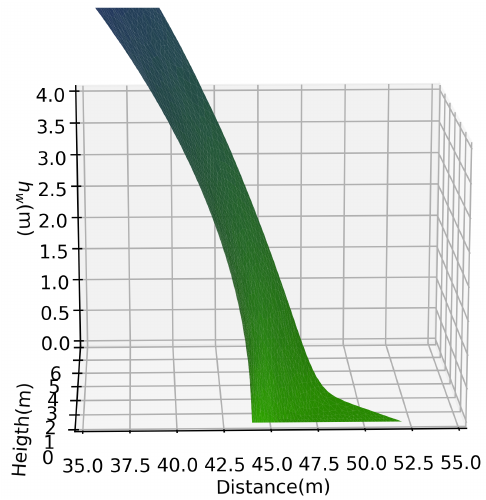
Figure 7. Zoomed in view of the solution near the drain at the lower right corner of the cross-section. The high gradient zone can be easily